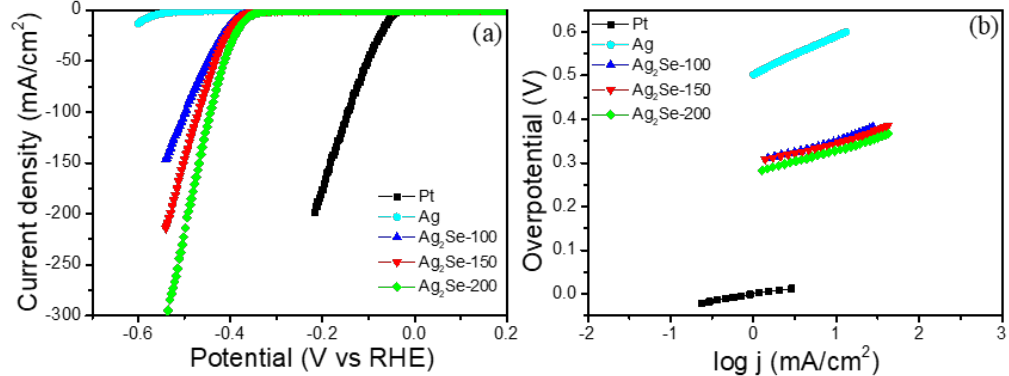
Figure 5. Electrocatalytic hydrogen evolution of different catalysts. ( a ) Polarization curves of commercial Pt, pure Ag (200 nm) and different thickness of Ag 2 Se and ( b ) their corresponding Tafel plots.